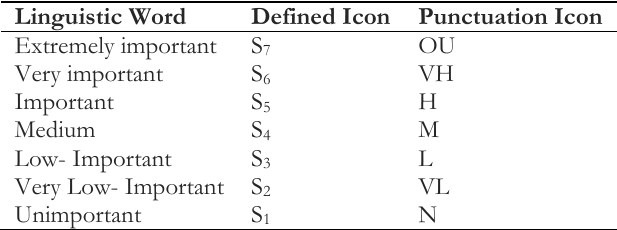
Table 3. Qualitative scale for evaluating criteria